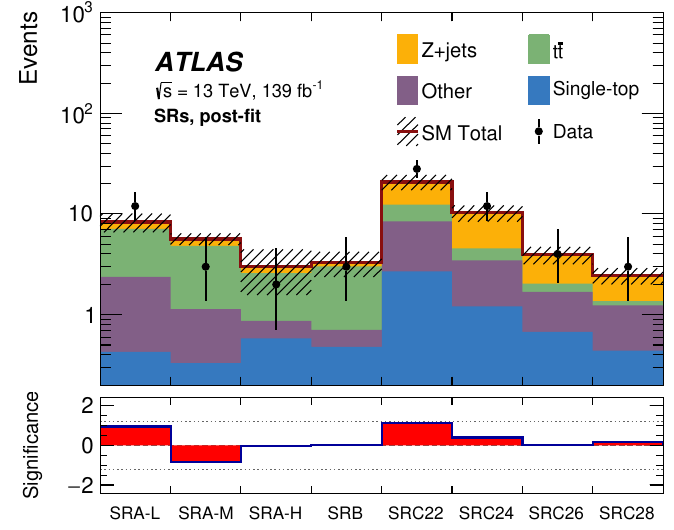
Figure 6. Results of the background-only (cid:12)t extrapolated to all SRs. The normalisation of the backgrounds is obtained from the (cid:12)t to the CRs. The upper panel shows the observed number of events and the predicted background yields. The backgrounds which contribute only a small amount (diboson, W +jets and t (cid:22) t + W=Z=h ) are grouped and labelled as \Other". All uncertainties de(cid:12)ned in section 7 are included in the uncertainty band. The lower panel shows the signi(cid:12)cance in each SR. The signi(cid:12)cance calculation is performed as described in ref.